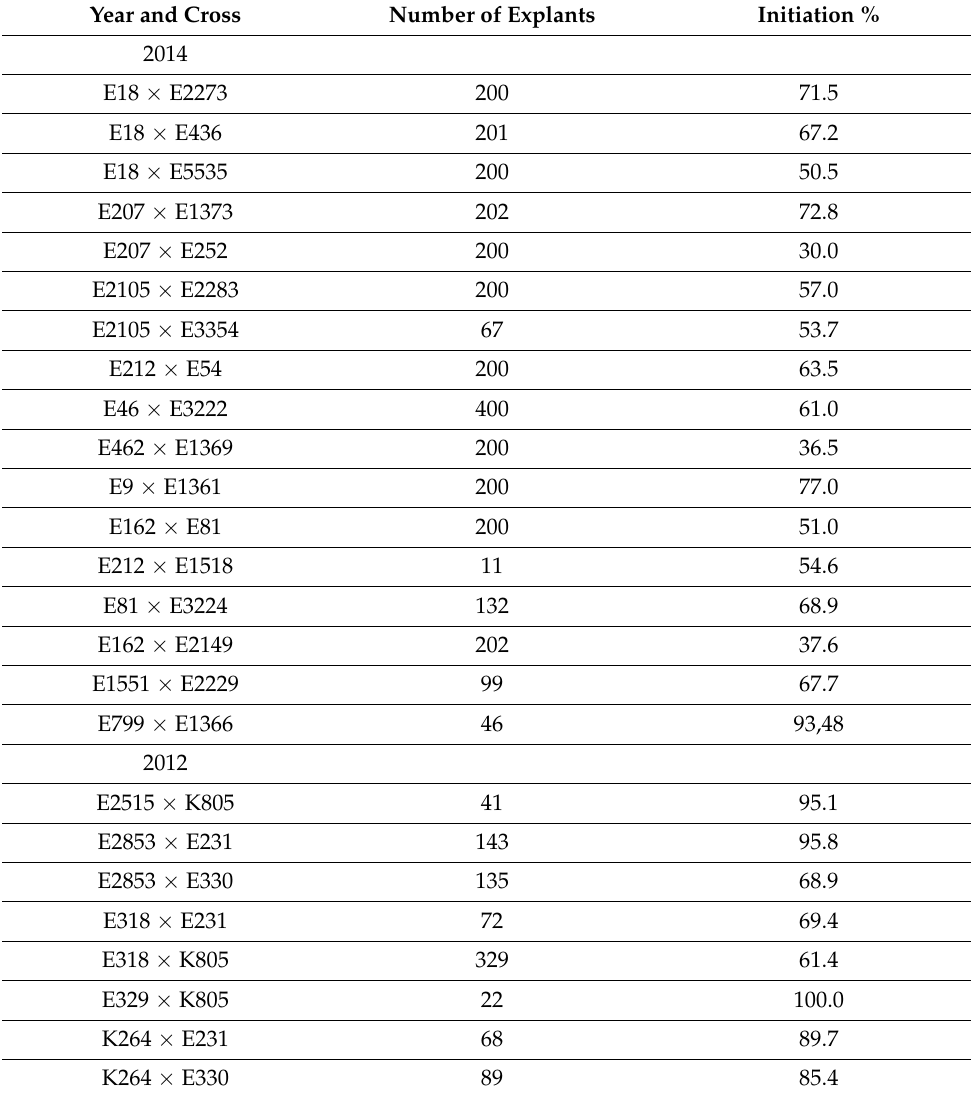
Table A1. Success of somatic embryogenesis (SE) initiation in the controlled crosses of Norway spruce used in the present